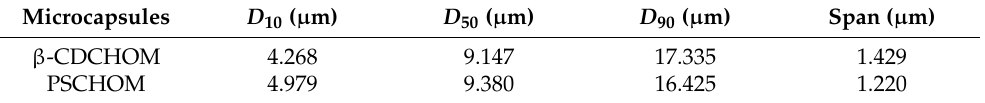
Table 2. Particle size distribution of cold-pressed hickory oil microcapsules.